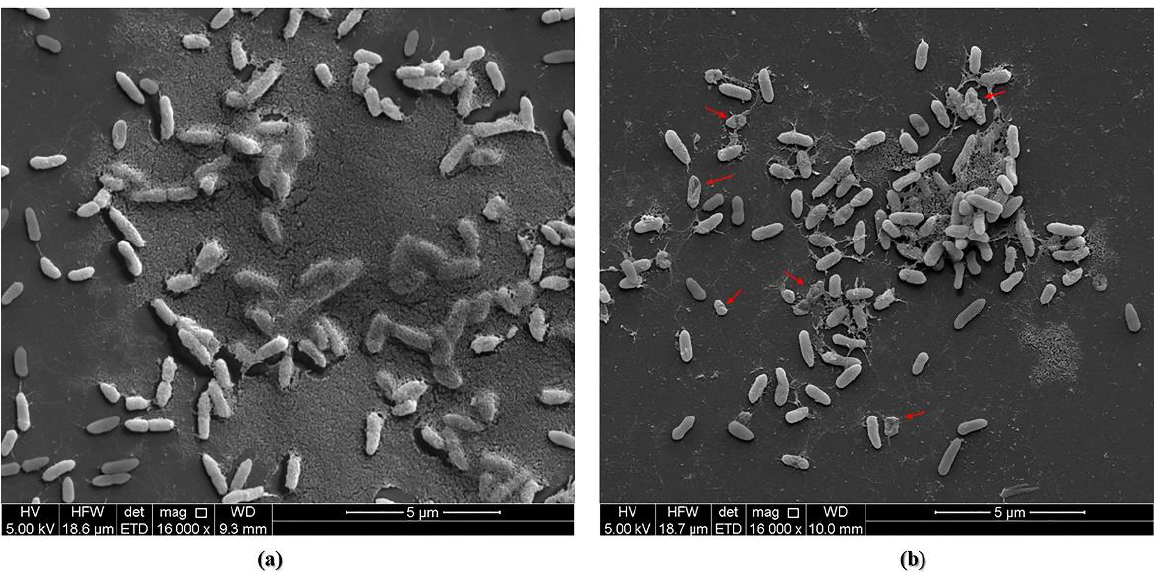
Figure 9. ( a ) SEM images of P. aeruginosa PAO1 biofilms demonstrates biofilm matrix covering large portions of the bacterial cells in negative controls sample, ( b ) SEM image representative of biofilms observed after treatment with GaPP-LCNP 3 µM and a light dose of 34.2 J/cm 2 . The biofilm matrix was disrupted, and the morphology of bacterial cell walls changed, presumably by the action of ROS.